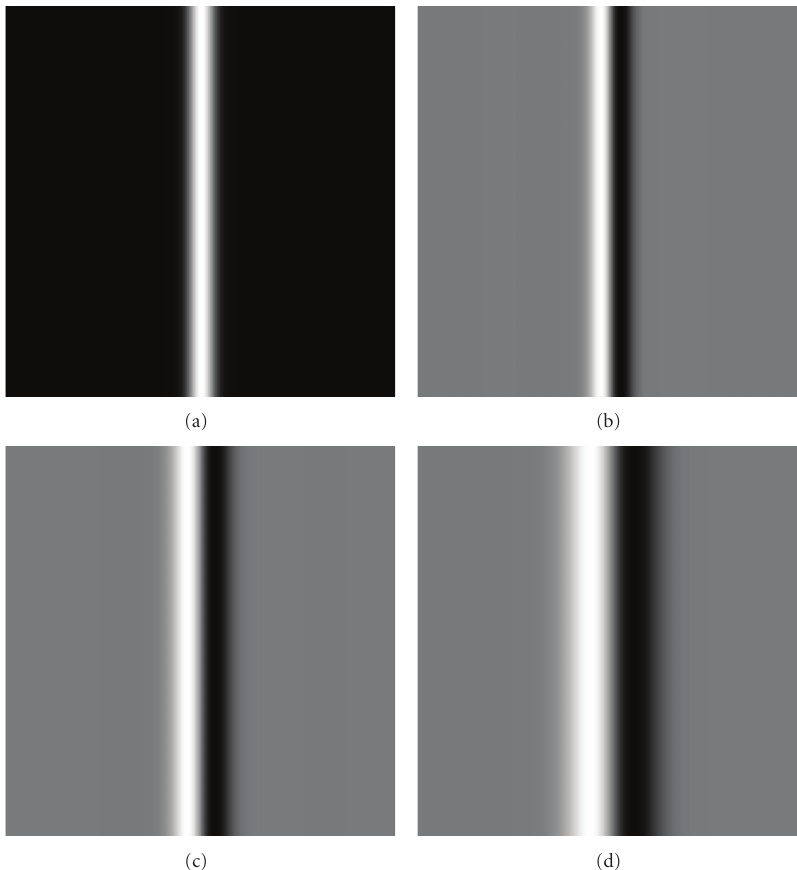
Figure 2: Original image convolved with first-order Gaussian derivatives. (a) Original image having an object with Gaussian intensity profile of kernel size σ = 5. (b) Original image convolved with first order Gaussian Derivative of kernel size σ = 1. (c) Original image convolved with first-order Gaussian derivative of kernel size σ = 5. (d) Original image convolved with first-order Gaussian derivative of kernel size σ =